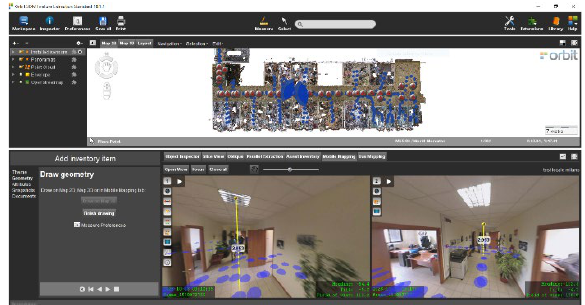
Figure 4: Particular of the Orbit cataloguing procedure